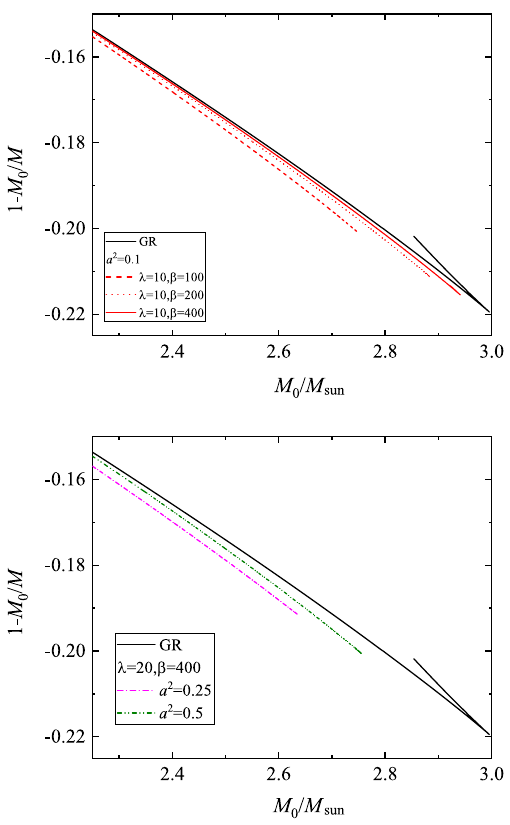
Fig. 4 The binding energy 1 − M 0 / M as a function of the rest mass of the star M 0 . Top: fixed value of a 2 and different values of λ and β . Bottom: fixed values of λ and β and different values of a 2 . The rest mass of the star is in solar masses explicitly given by ϕ = (χ( r ), Θ = θ, (cid:11) = φ) . We